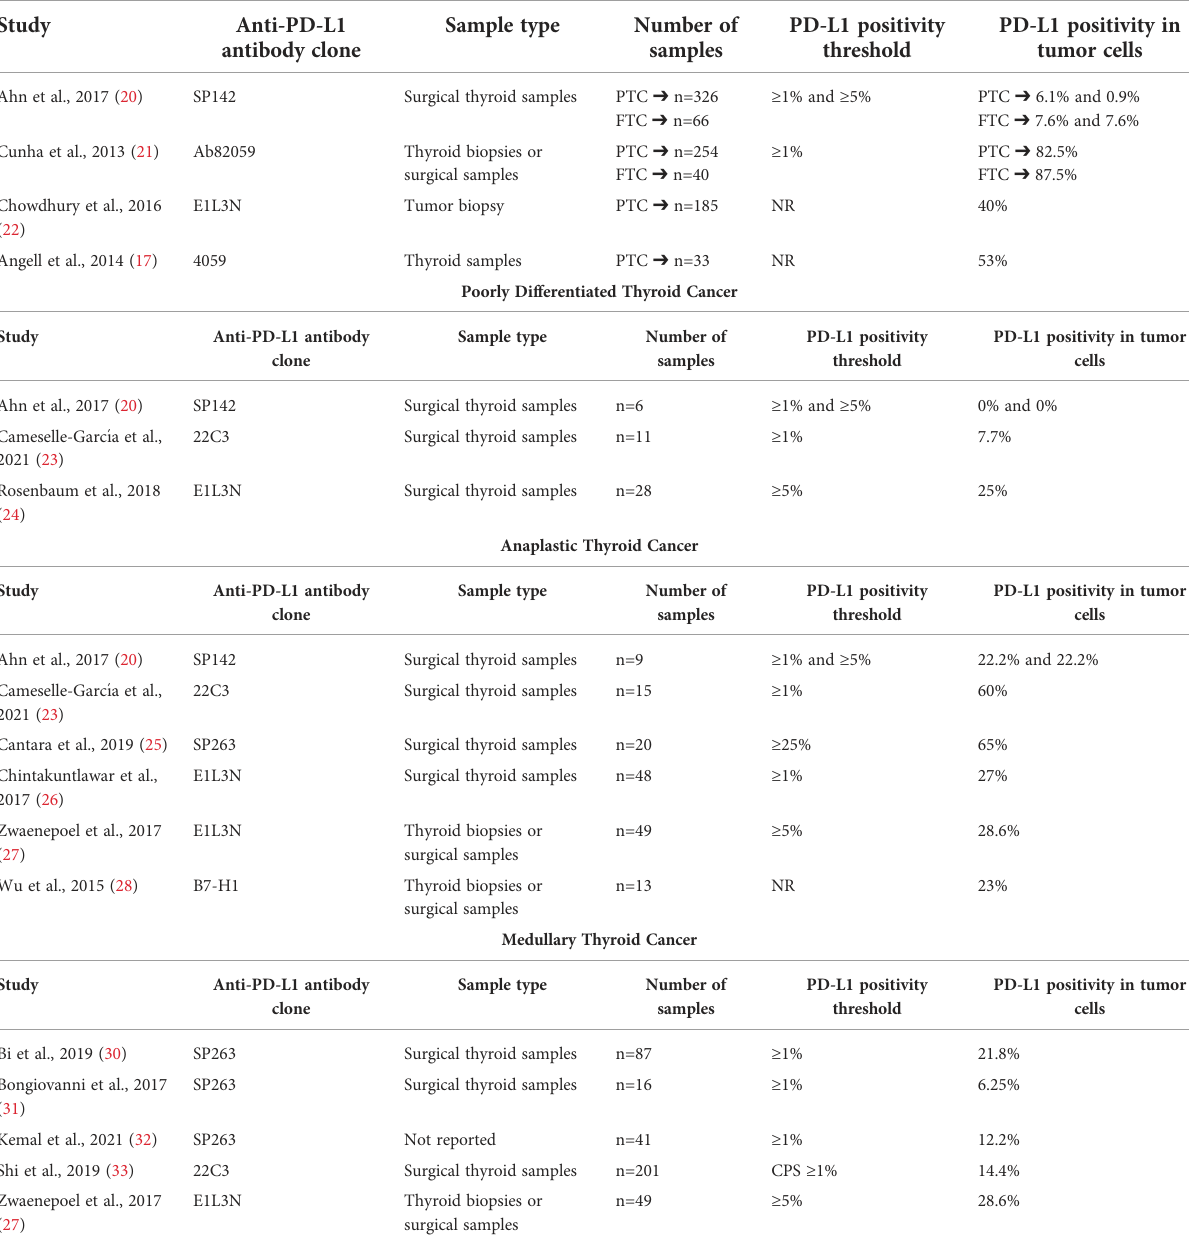
TABLE 1 PD-L1 positivity in tumor cells in different subtypes of thyroid